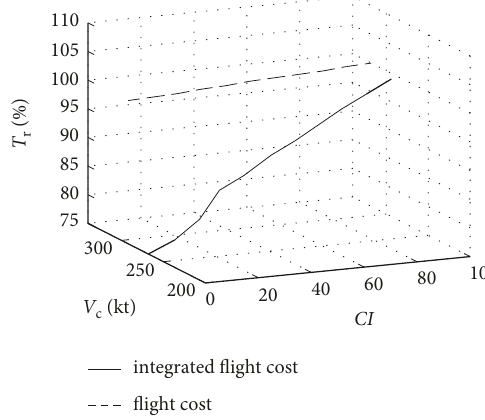
Figure 8: Effect of CI on optimization parameters.